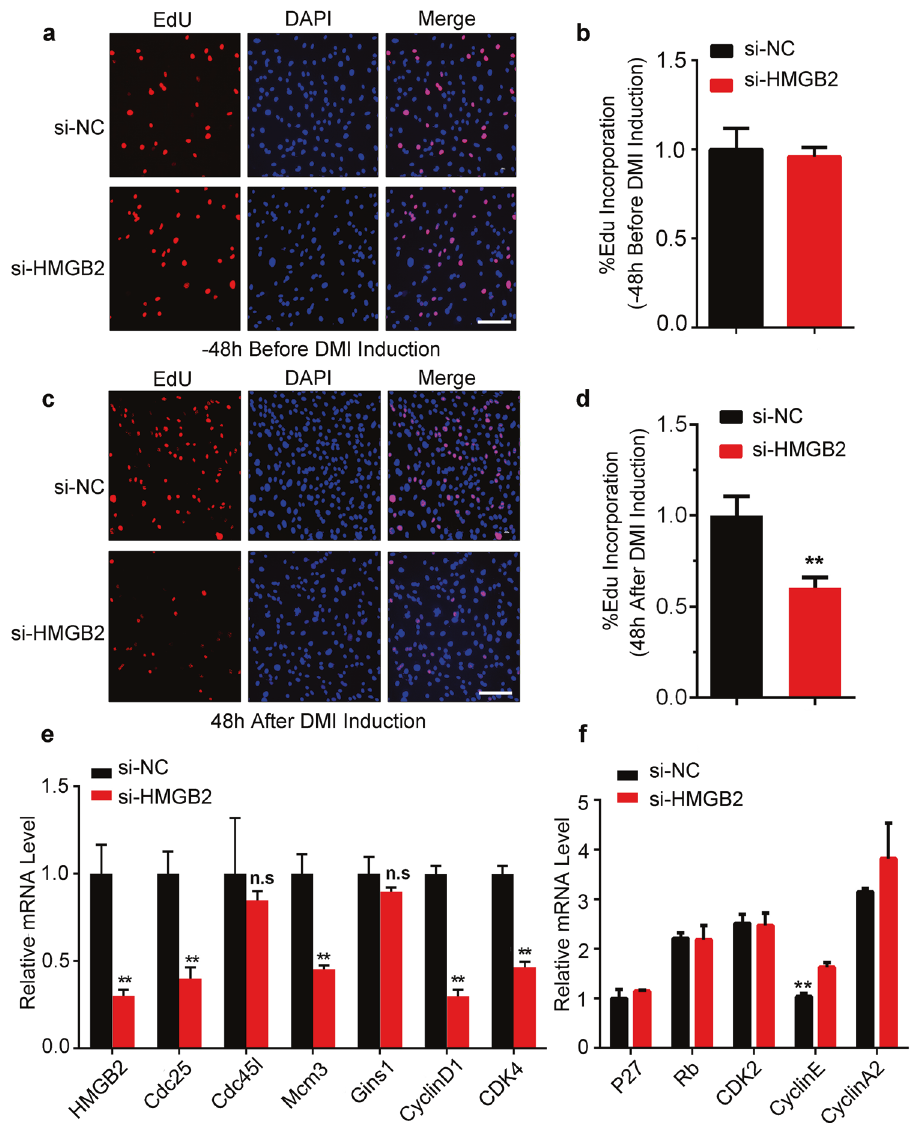
Fig. 2 HMGB2 promotes mitotic clonal expansion in adipogenesis. a – d Detection of cell proliferation at different stages after HMGB2 interference by using immuno fl uorescence assay. e, f qPCR for mRNA of MCE-speci fi c genes and cell-cycle genes affected by si-HMGB2 in 3T3- L1 cells. ( b, d – f : n = 3, ** P < 0.01; * P < 0.05 against si-NC, Students ’ t test; data presented in graphs represent mean ±